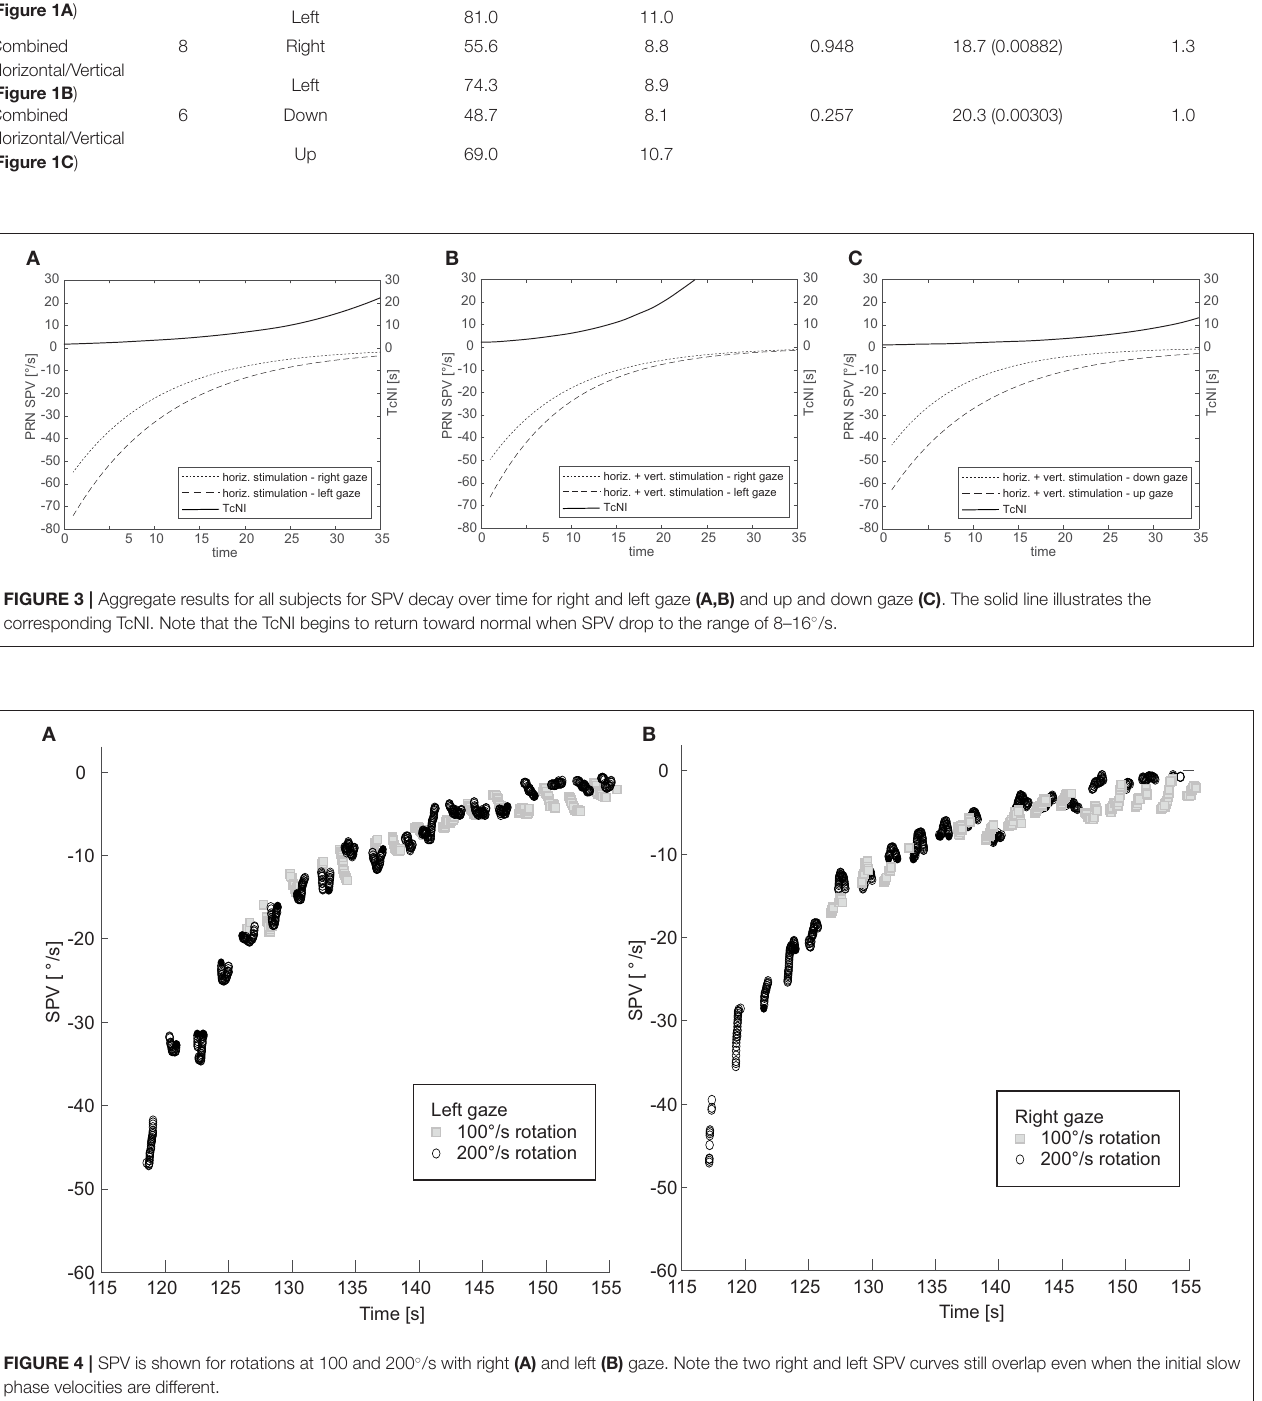
Frontiers in Neurology |